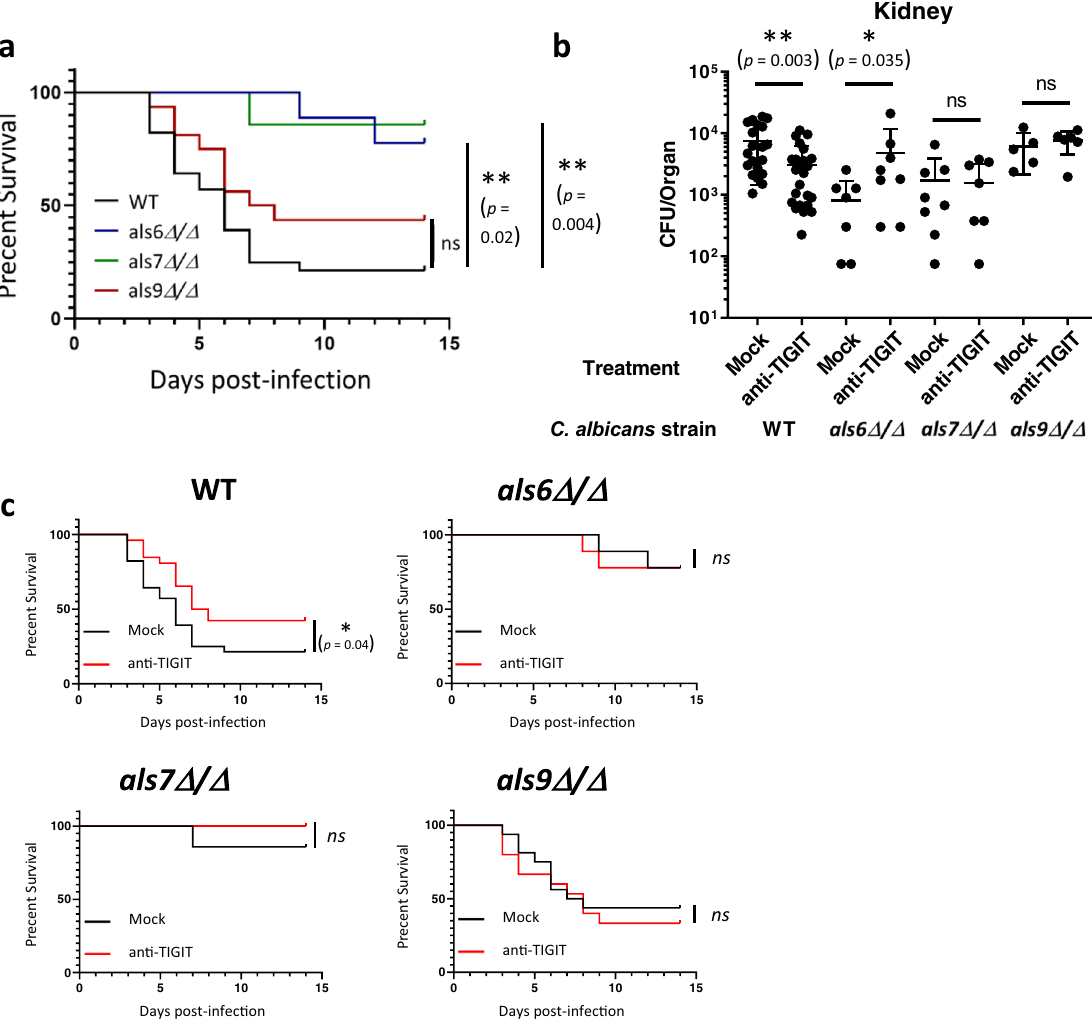
Fig. 6 Als-mediated immune evasion can be prevented using TIGIT-targeted immunotherapy in mice. a Survival of mice infected with 6.5×10^5 CFU/ mouse of the WT C. albicans strain SC5314 (black line) or a mutant strain deleted for ALS6 (blue line), ALS7 (green line), or ALS9 (red line). Each line represents 7 – 28 mice from 2 – 5 independent experiments. b C. albicans burden in the kidneys 48h post I.V. infection of C57BL/6 mice. The mice were infected with either WT or ALS6, ALS7 or ALS9-deleted fungal cells and either treated or not with a TIGIT-blocking antibody. Kidneys were harvested, processed, and seeded on Sabouraud dextrose agar plates. n = 5 – 25 animals examined over 2 – 5 independent experiments. Data are presented as mean values ± SD. c Survival of mice infected with 6.5×10^5 CFU/mouse of the WT C. albicans strain SC5314 or a mutant strain deleted for ALS6, ALS7, or ALS9, and either mock treated (black line) or treated with a TIGIT-blocking antibody (red line). Each line represents 7 – 28 mice from 2 – 5 independent experiments. Data for the mock-treated mice is shared with ( a ). Error bars represent the standard error. For the fungal burden, signi fi cance was tested using a two-tailed Mann – Whitney test. For the survival assay signi fi cance was tested using Mantel – Cox log-rank test. ns = not-signi fi cant, * = p <0.05, ** = p